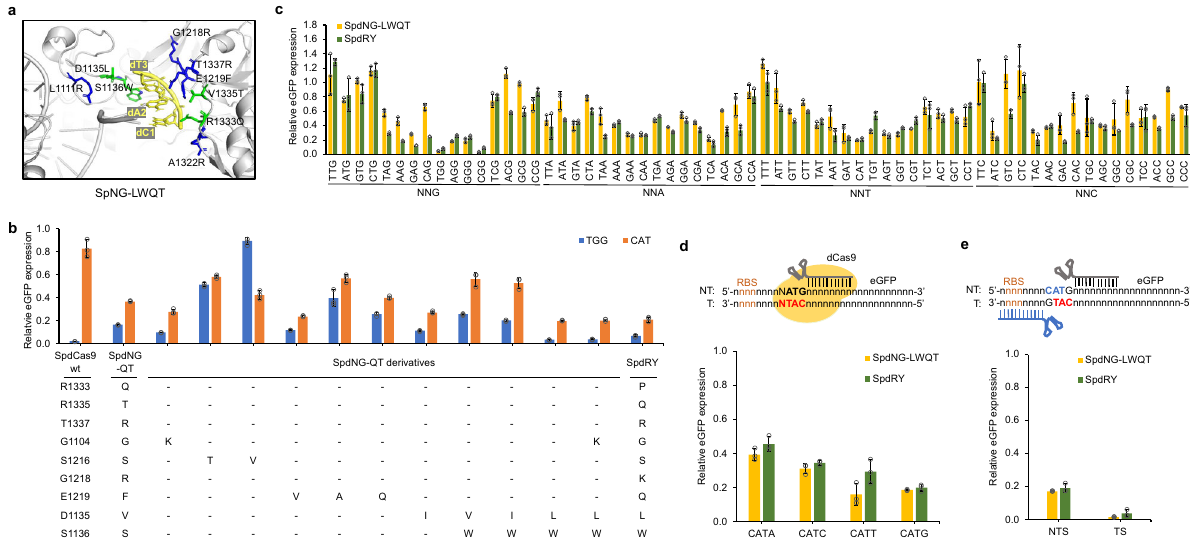
Fig. 2 Improving the activity of SpdNG-QT toward 5 ′ -CAT-3 ′ PAM by mutating PAM-proximal residues. a PAM-proximal residues involved in PAM recognition. Modeled structure of SpNG-LWQT (D1135L/S1136W/R1333Q/V1335T, residues shown in green) with 5 ′ -CAT-3 ′ PAM based on SpNG (PDB ID: 6AI6). b Impact of mutating PAM-proximal residues on 5 ′ -TGG-3 ′ (blue) and 5 ′ -CAT-3 ′ (orange) PAM recognition. c PAM pro fi le comparison between SpdNG-LWQT (gold) and SpdRY (green) against all NNN PAM libraries. d The in fl uence of the fourth-position base on 5 ′ -CAT-3 ′ PAM recognition of SpdNG-LWQT (gold) and SpdRY (green). e The repression effects of SpNG-LWQT (gold) and SpdRY (green) when targeting 5 ′ -CAT-3 ′ PAM on both nontemplate and template strand. NTS nontemplate strand, TS template strand, RBS ribosome binding site. Data indicated the mean ± standard deviation ( n = 3 independent biological replicates). Source data are provided as a Source Data fi